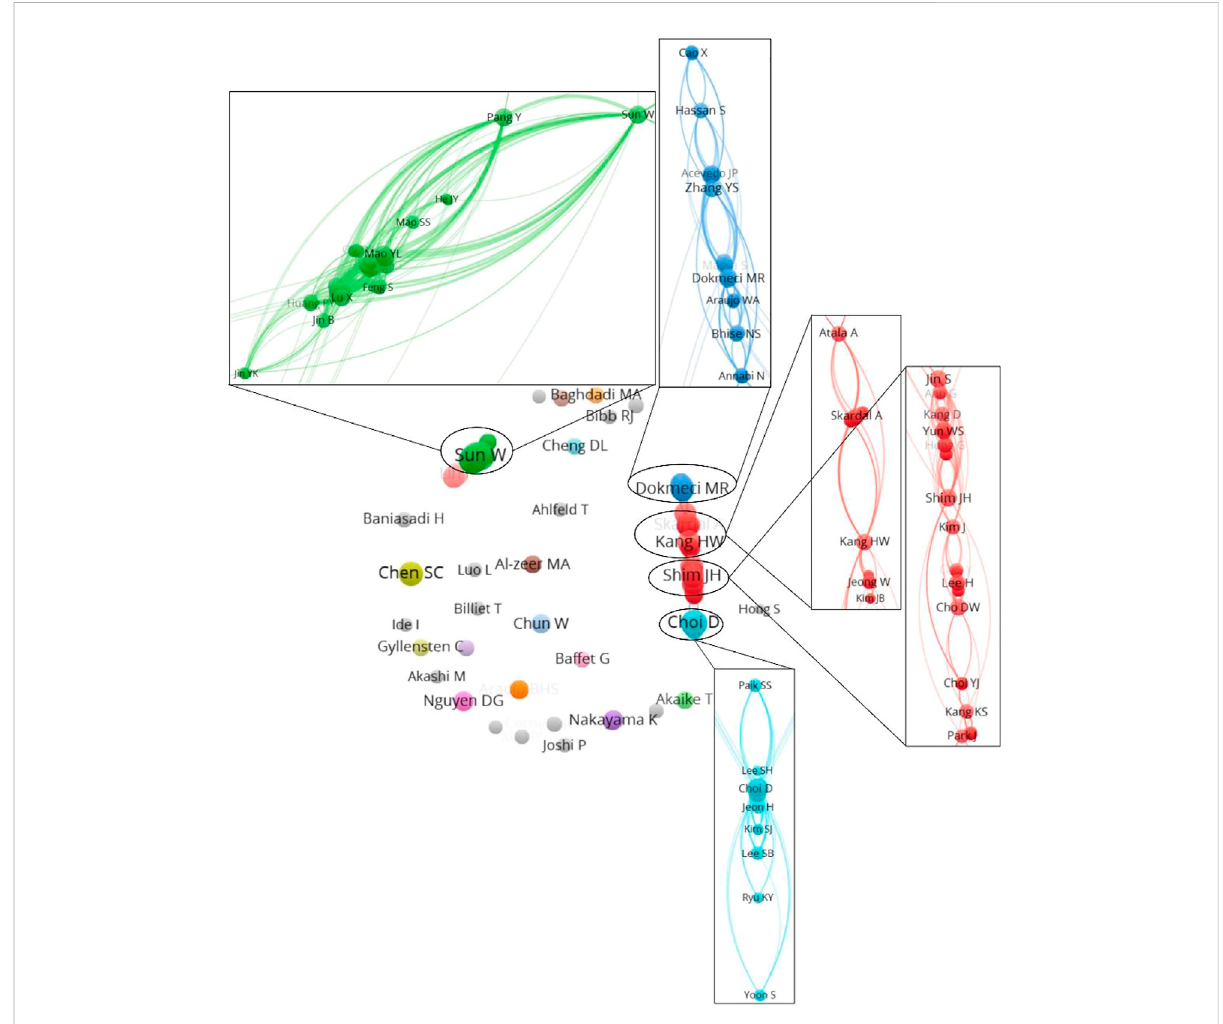
FIGURE 5 The cooperation relationships of authors that published articles.